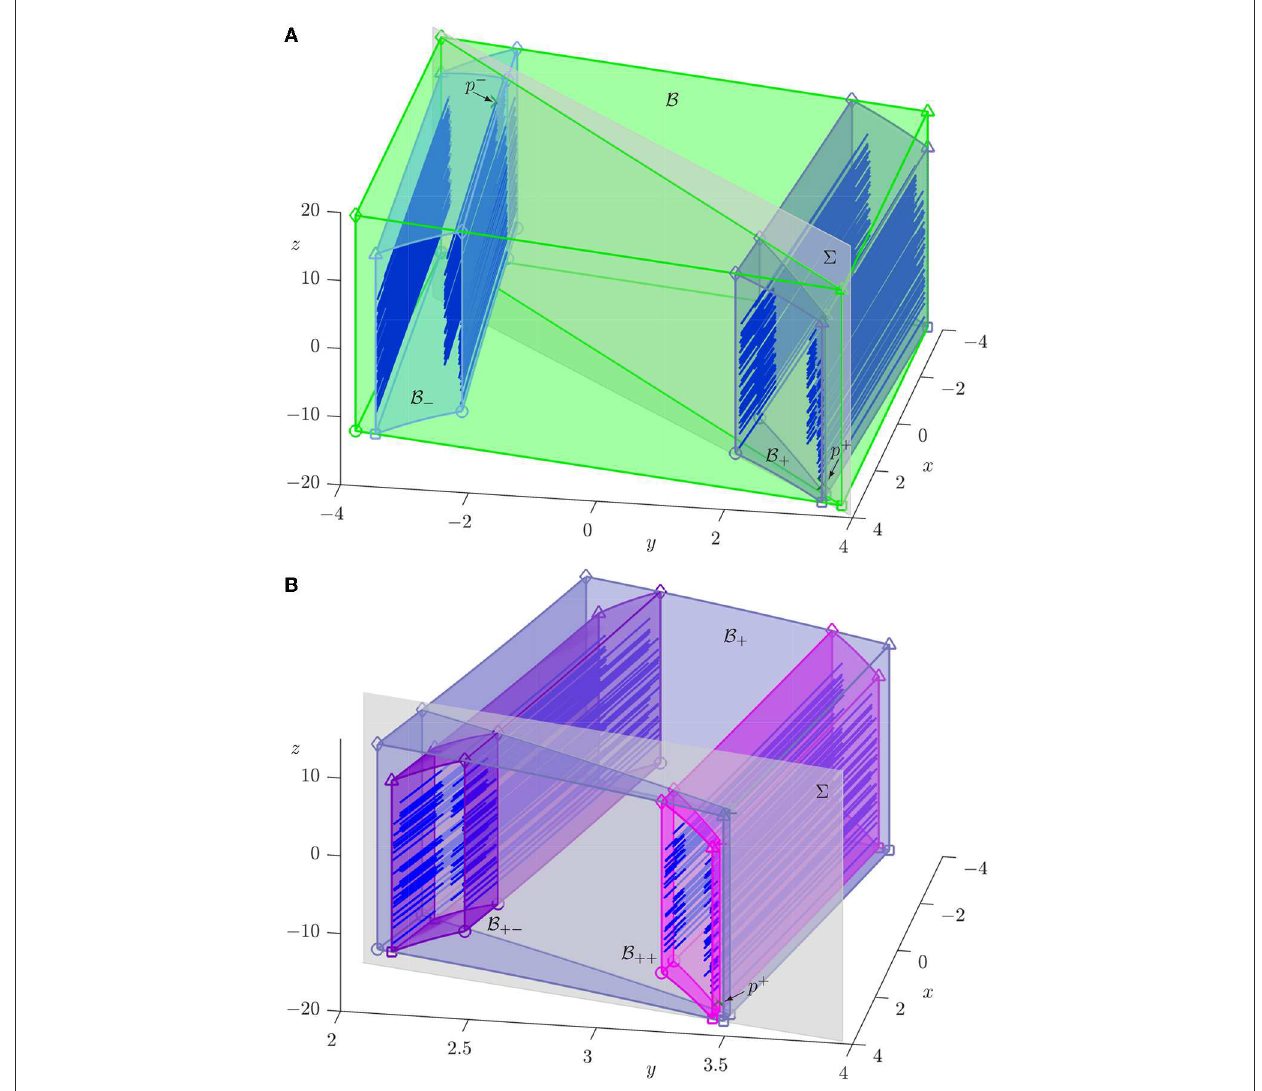
FIGURE3 First 450 segments of W s ( p ± ) ∩ B (blue curves) for ξ = 1.2, shown in (A) inside B (green), B − (light blue), and B + (dark blue), and in (B) inside B + (dark blue), B +− (purple), and B ++ (magenta); also shown are p ± (green crosses) and the diagonal plane 6